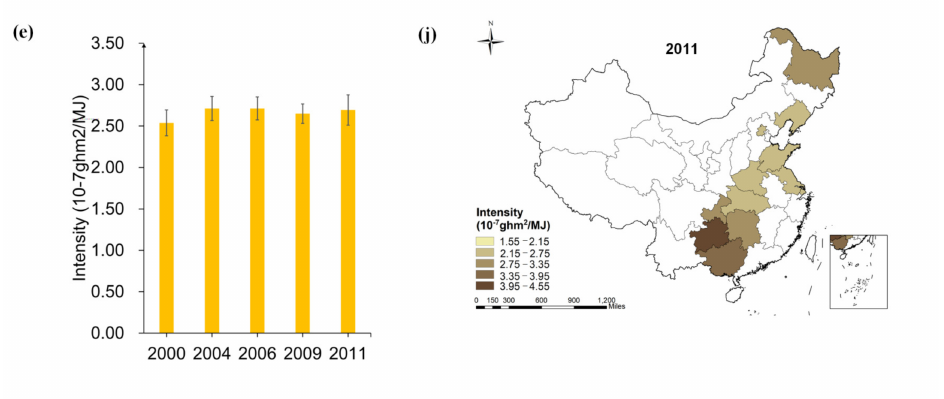
Figure 4. Spatial-temporal characteristics of multiple footprint intensity of energy intake (( a , f ): WF; ( b , g ): CF; ( c , h ): NF; ( d , i ): EF; ( e , j ): LF; The error lines in the figure are standard errors). Dietary WFI e , NFI e , LFI e of Guizhou household is the highest, respectively, reached 1.86 × 10 − 3 m 3 /MJ, 2.76 × 10 − 5 g/MJ, 4.53 × 10 − 7 ghm 2 /MJ. CFI e of Hunan household is the highest (1.13 × 10 − 3 kgCO eq/MJ). EFI e of Shandong household is the lowest 2 (2.51 × 10 − 3 MJ/MJ), and that of Beijing household is the highest (4.55 × 10 − 3 MJ/MJ).